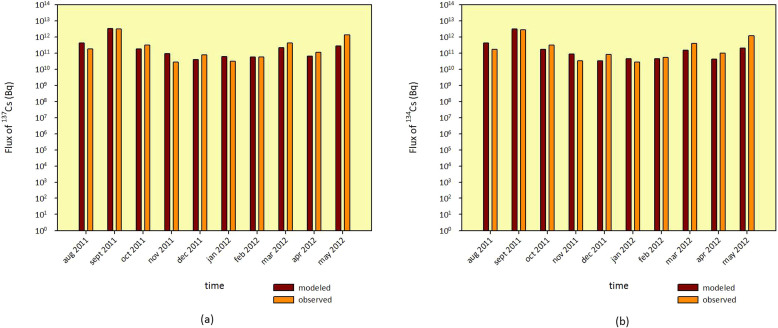
The comparison of modeled data and observed data for 137Cs (a) and 134Cs (b).